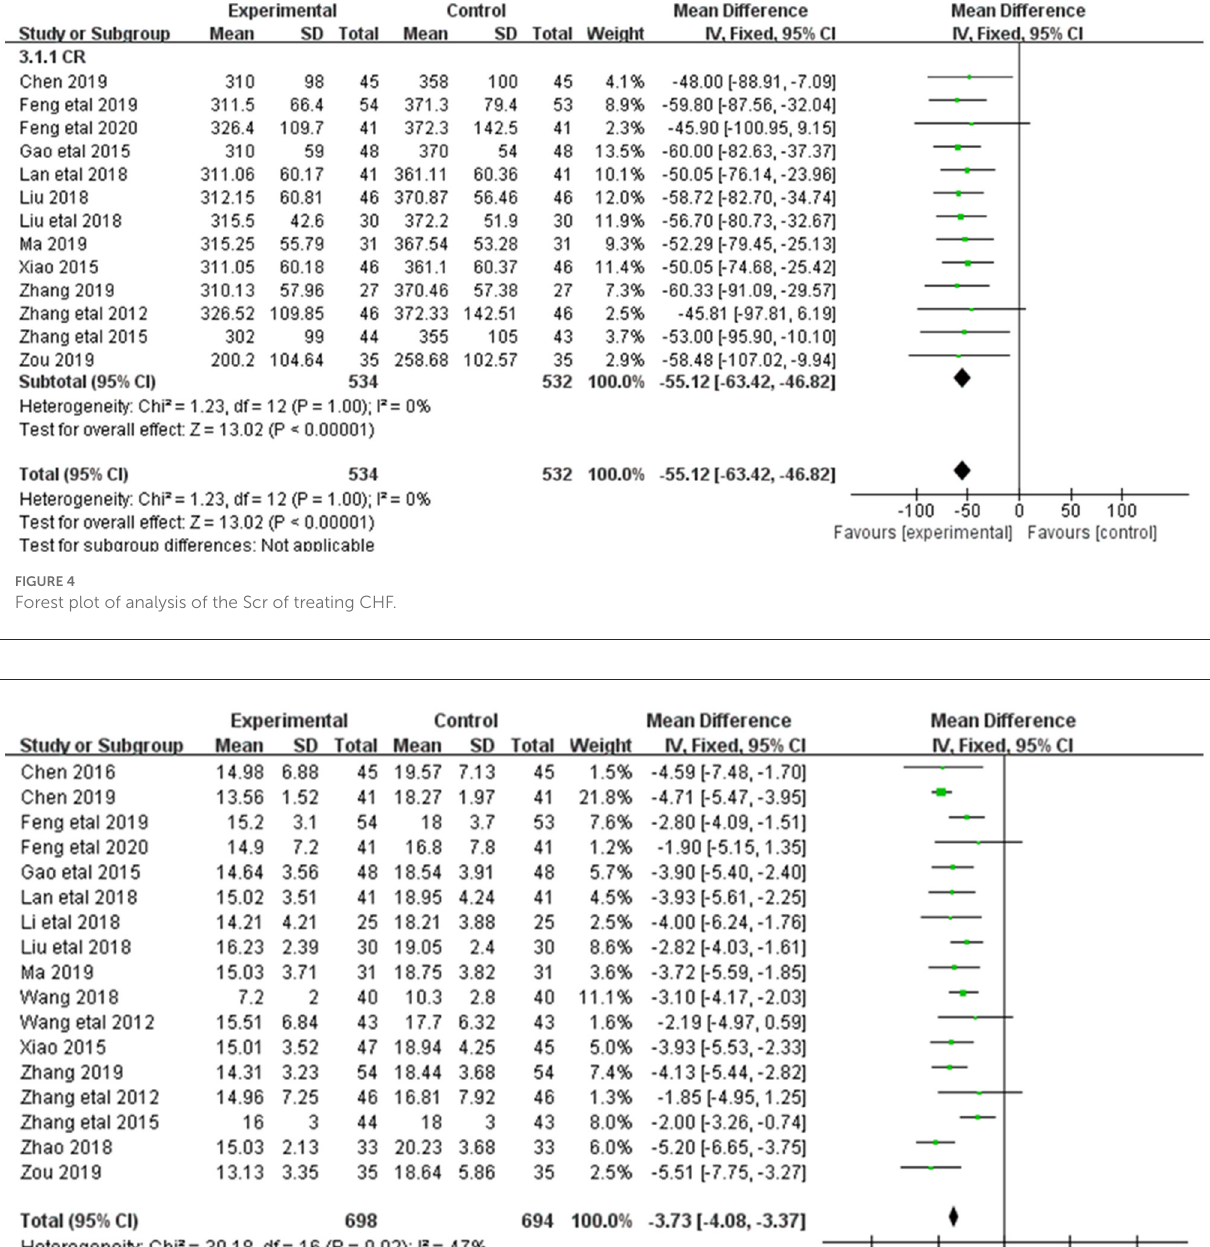
FIGURE5 Forest plot of analysis of the BUN of treating CHF.